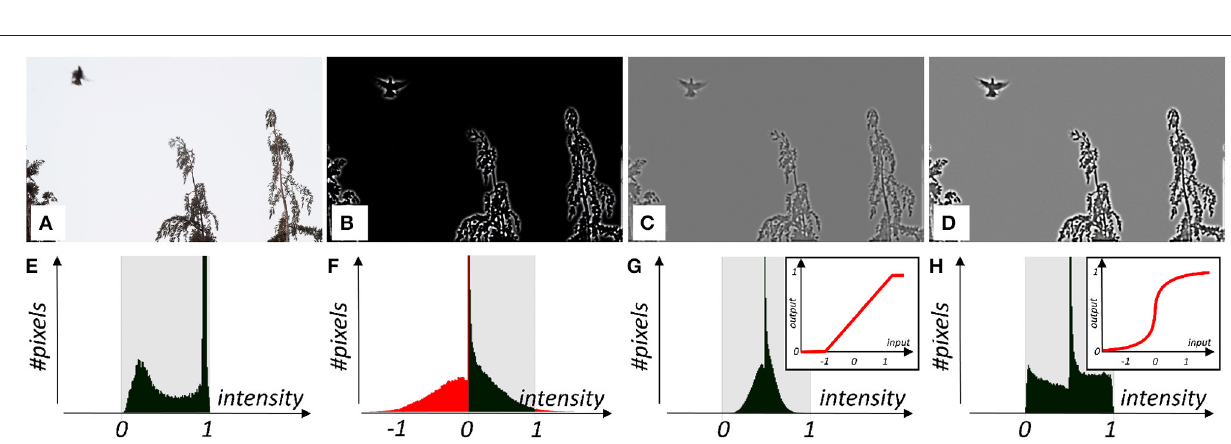
Supplementary section 3.5 reviews applications of virtual